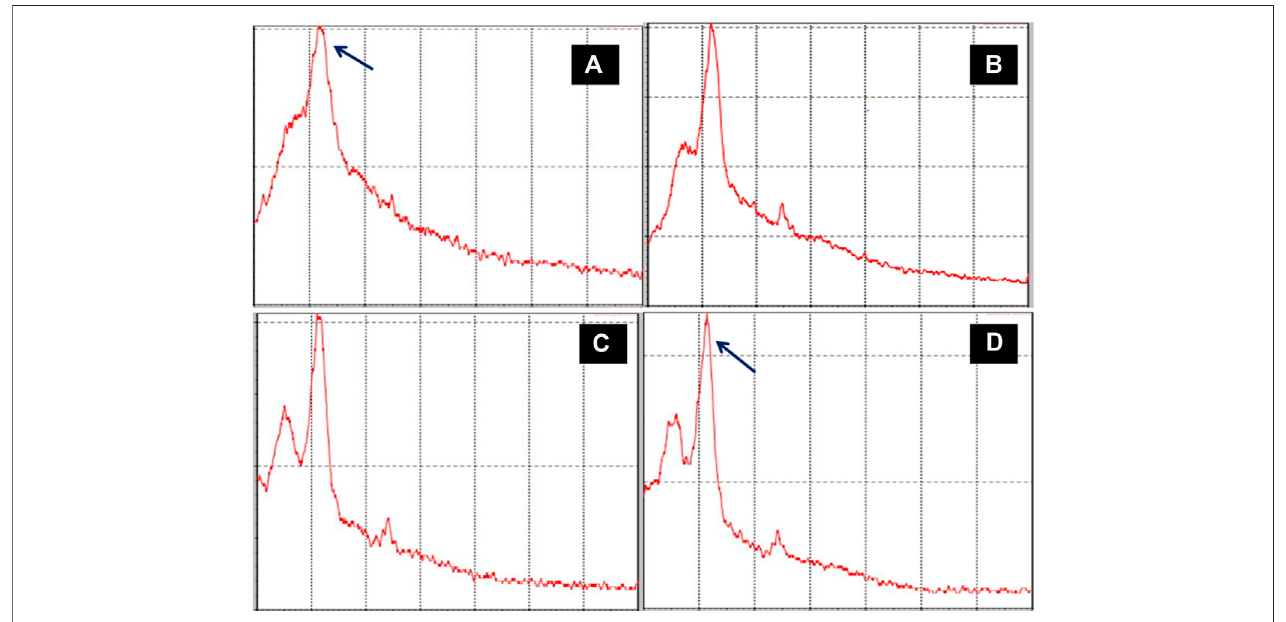
FIGURE 7 | X-ray diffractograms of different chemical pretreated residues, (A) raw corn cob biomass, (B) NaOH-pretreated residues, (C) HNO 3 -pretreated residues, and (D) NaOH-pretreated and acid-hydrolyzed residues.